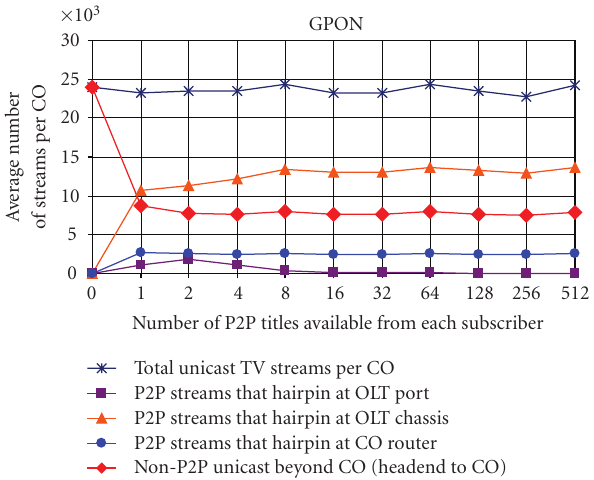
Figure 6: Number of streams with GPON limits on upstream P2P Capacity.